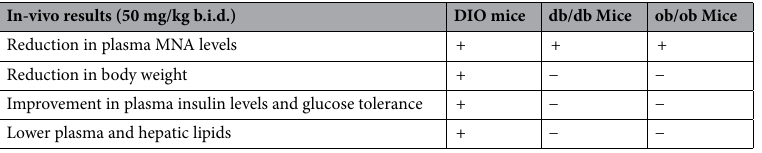
In-vivo results (50 mg/kg b.i.d.)